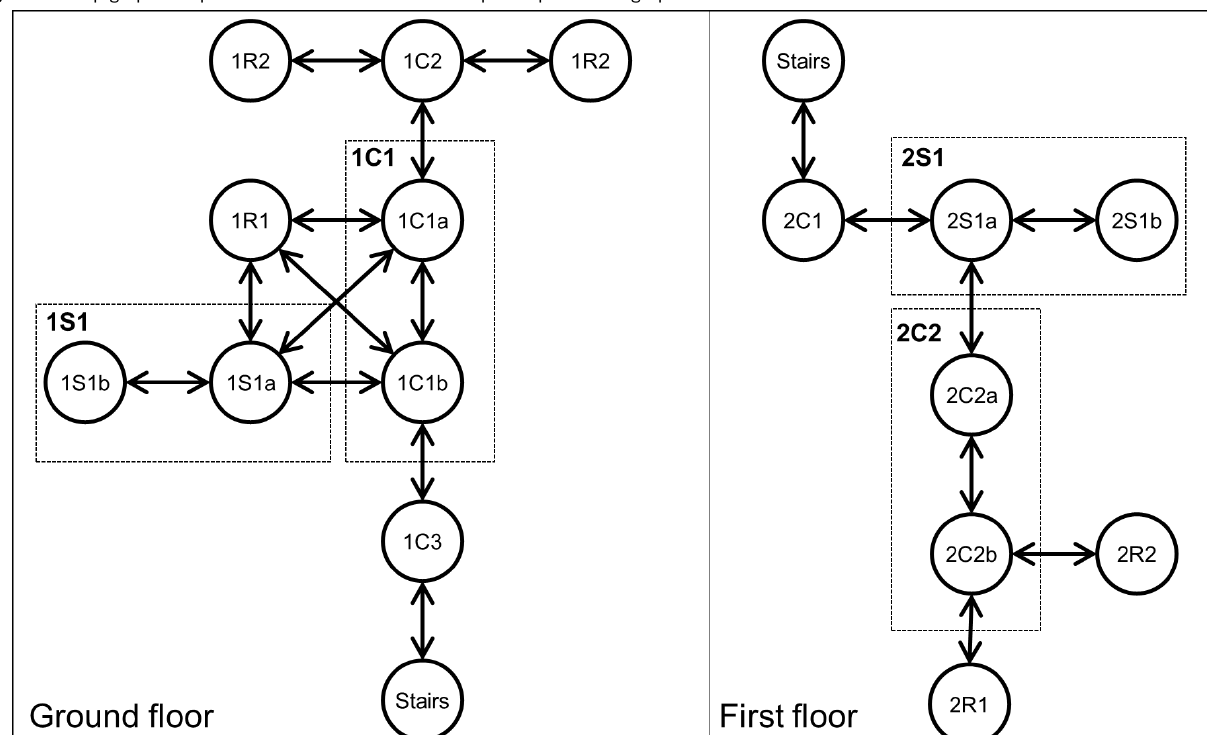
Figure 4. Map graph: the position of the beacons in the map transposed as a